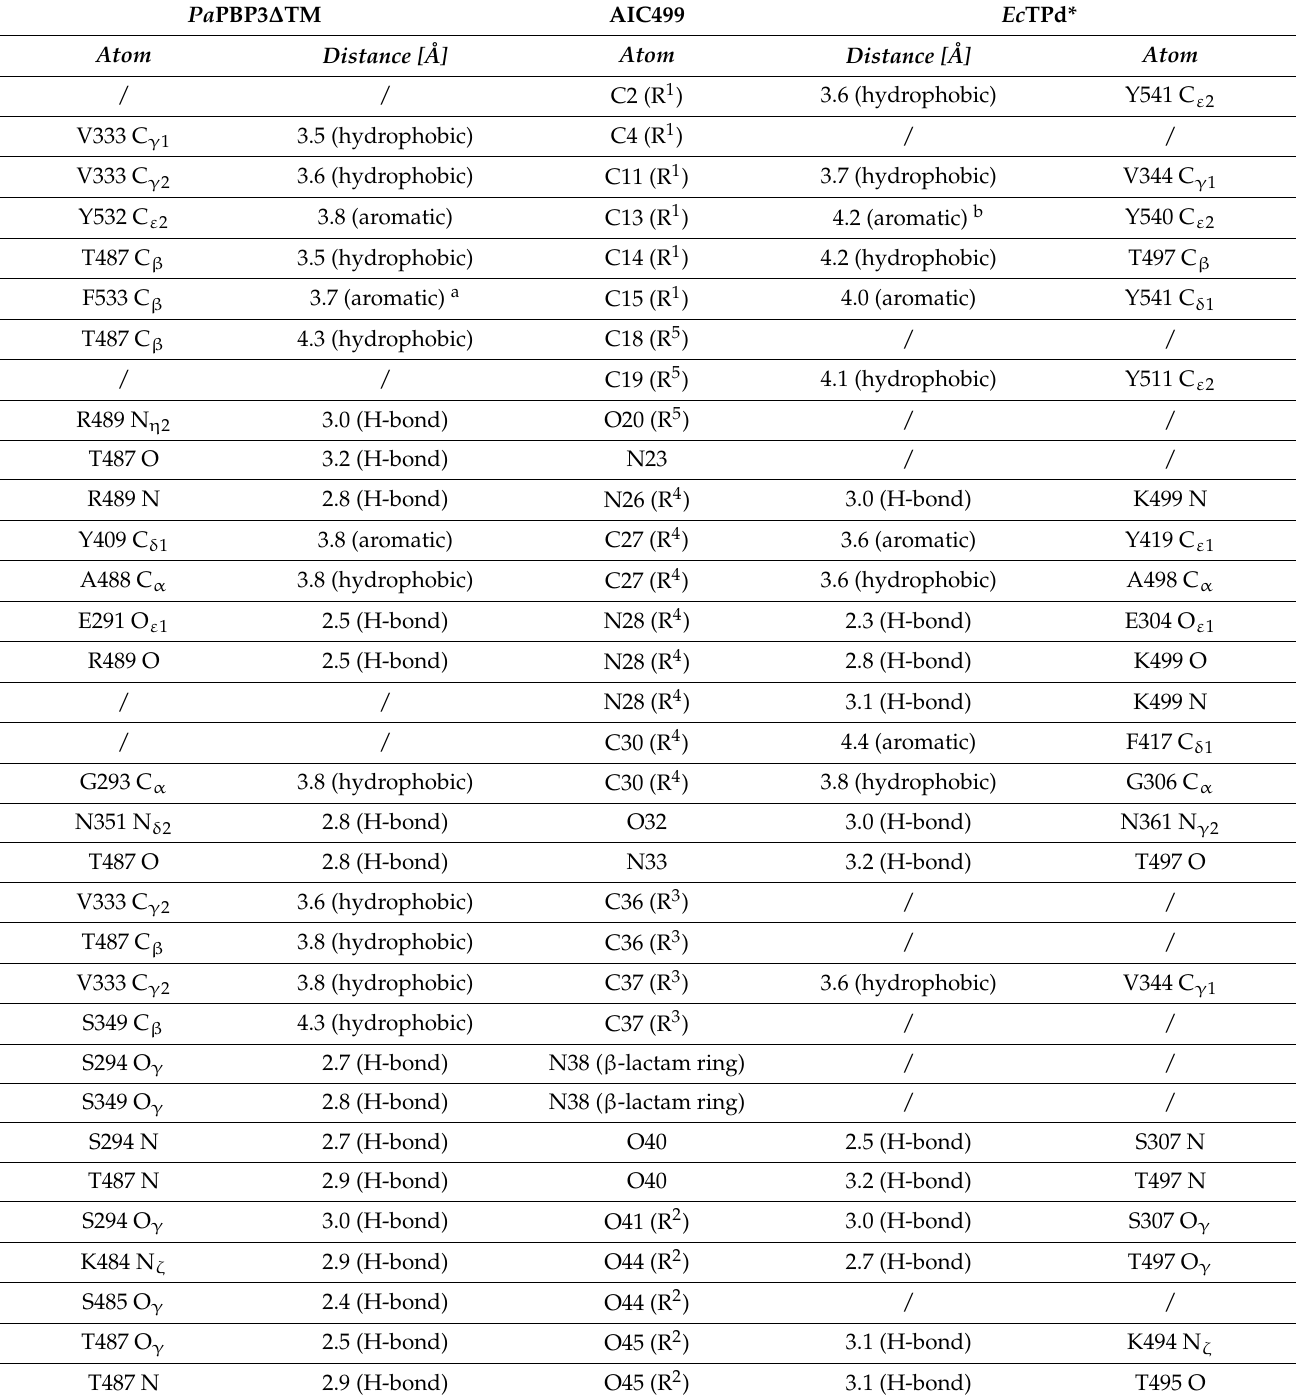
Table A1. Overview of the distances between atoms of AIC499 (center) and Pa PBP3 ∆ TM (chain B, left) or Ec TPd* (right). The type of interaction as well as the functional group which the respective AIC499 atom belongs to are given in parentheses. See Figure 1 for the nomenclature of AIC499 atoms. Hydrogen bonds are included with donor-acceptor distances ranging from 2.3 to 3.2 Å, and hydrophobic and aromatic interactions are listed for distances between 3.0 and 4.5 Å. For distances differing between both conformers, the smaller value is